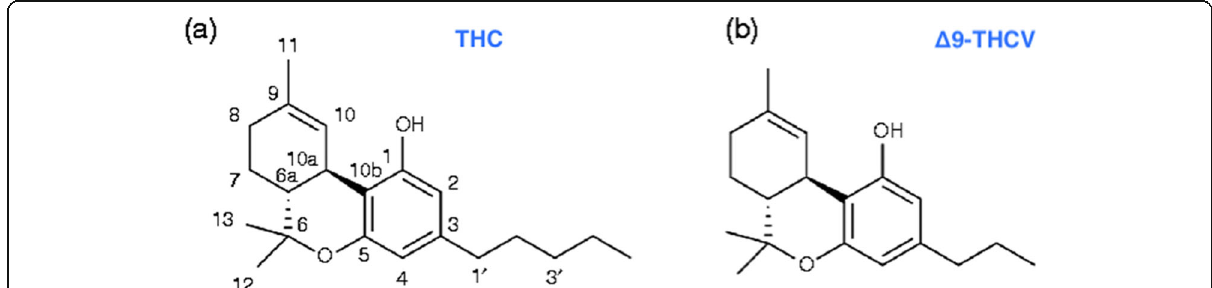
Fig. 1 Molecular Structures of THC ( a ), and THCV ( b ). Data sourced from Jager and colleagues in The Endocannabinoid System and Appetite: Relevance for Food Reward